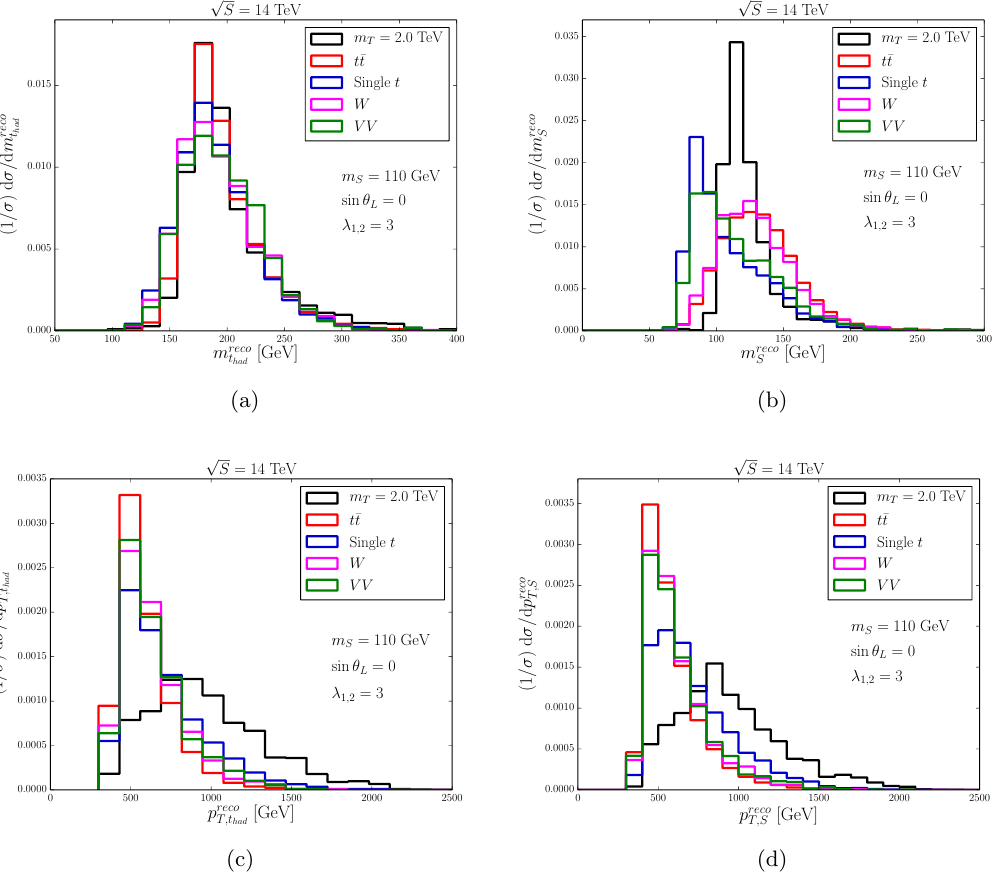
Figure 17 . Reconstructed invariant mass distributions of the (a) top-tagged fat jet and (b) scalar- tagged fat jet for m T = 2 TeV. The corresponding p T distributions are shown in (c) and (d) together with background distributions. All plots are generated based on events after showering, hadronization, and detector e(cid:11)ects. Our model parameters are m S = 110 GeV, (cid:21) 1 ; 2 = 3 and sin (cid:18) L = 0. Basic cuts in eqs. (6.8){(6.11) have been applied.